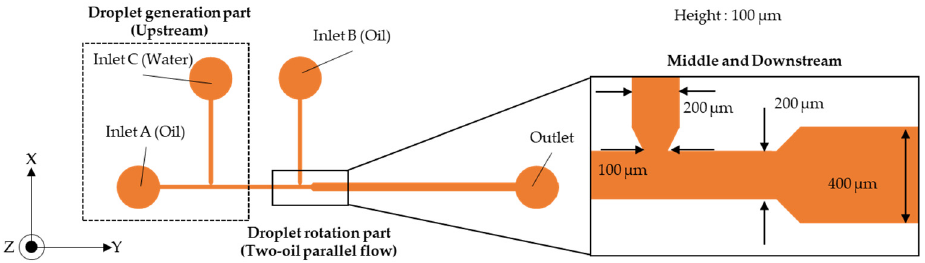
Figure 2. Schematic view and size details of the microdroplet rotation device.